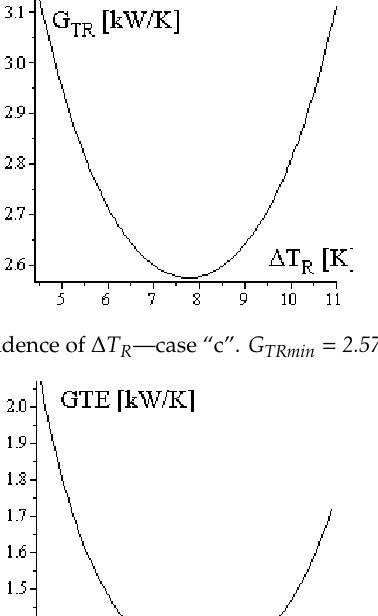
TEmin = 1.628 for Δ T H = 204.75 K.